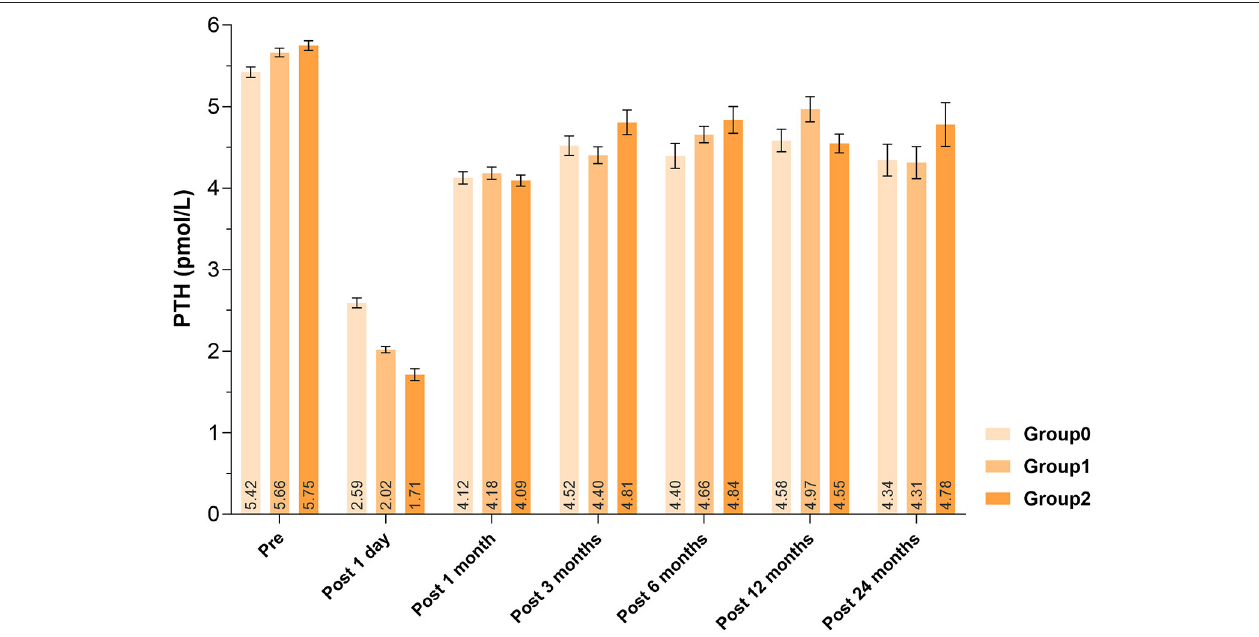
FIGURE 2 | Changes of parathyroid hormones among groups. Pre, pre-operative; Post, post-operative.